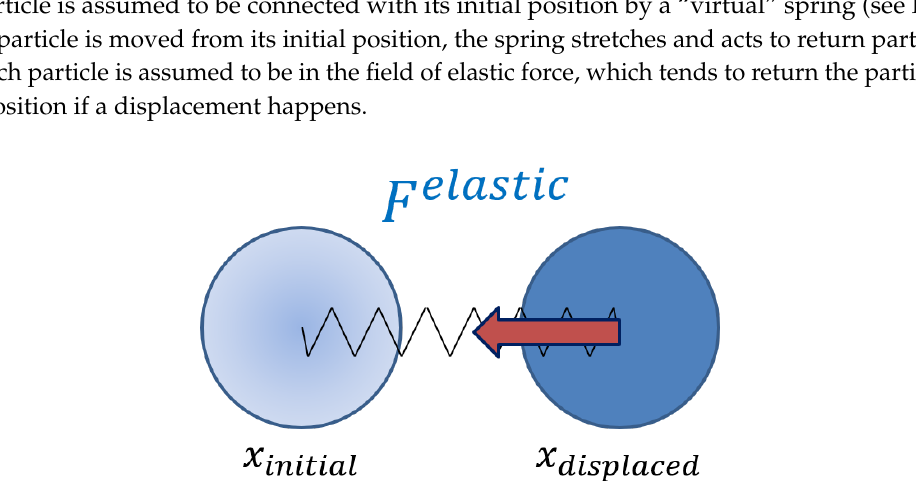
Figure 2. When a particle is moved from its initial position x initial , the elastic returning force F elastic